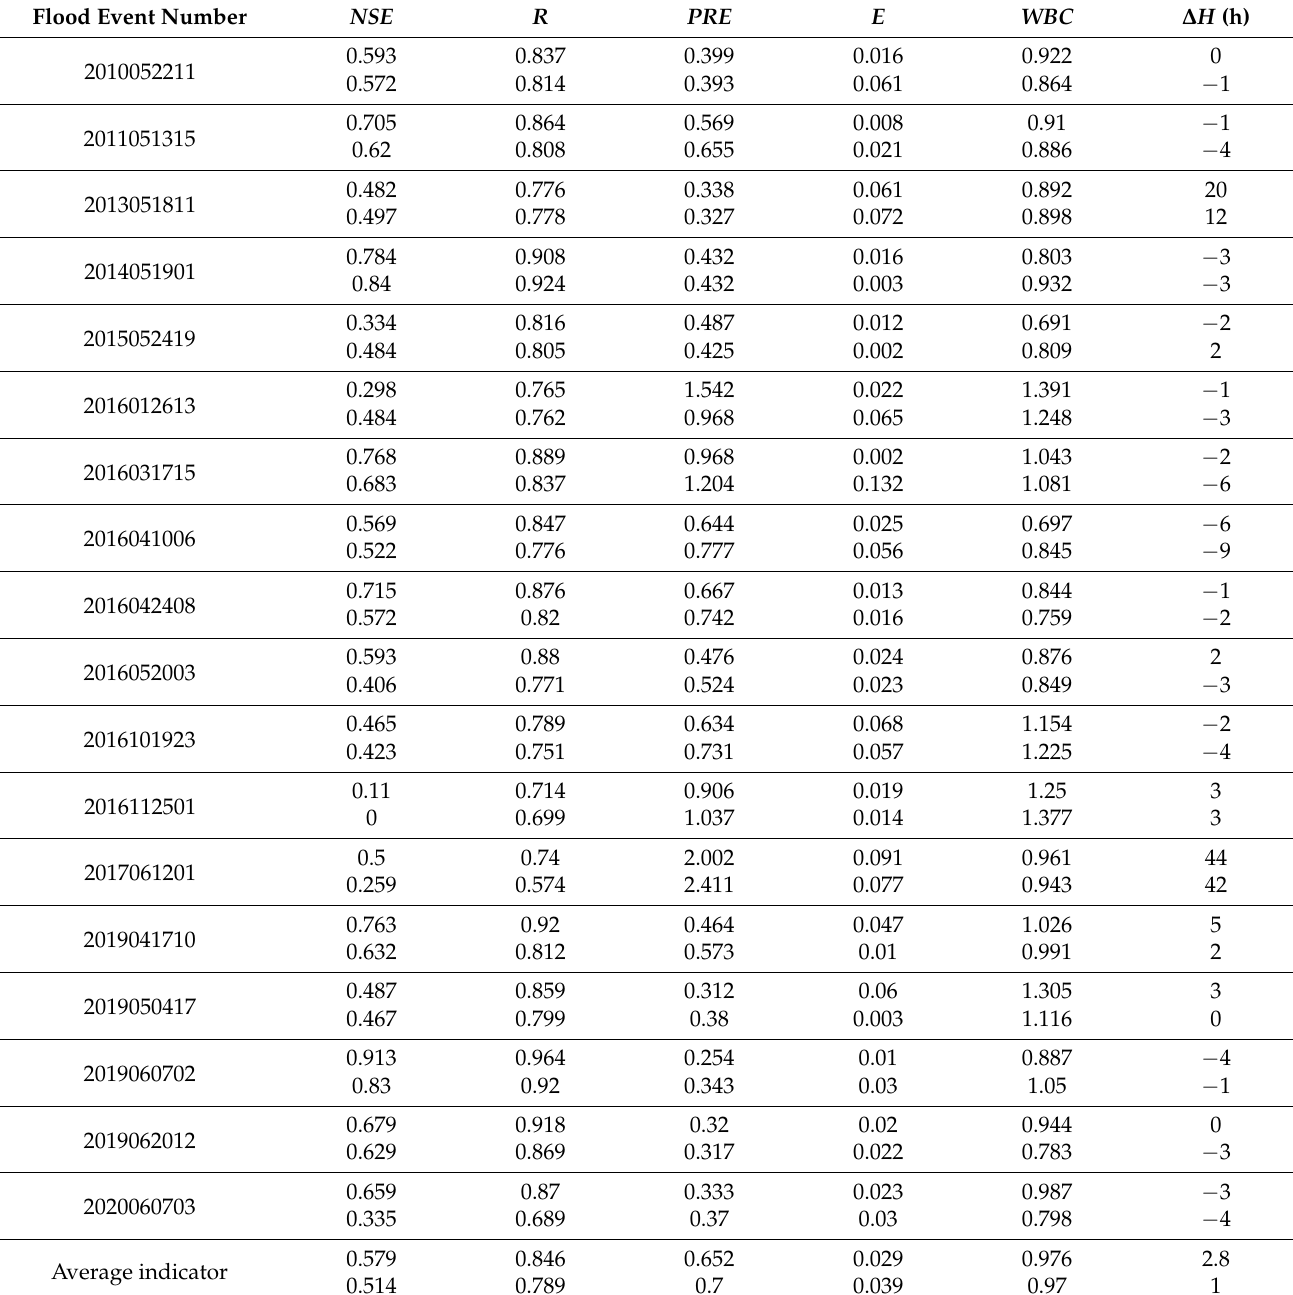
Table 7. Comparison of statistical indicators for the flood simulation in different river